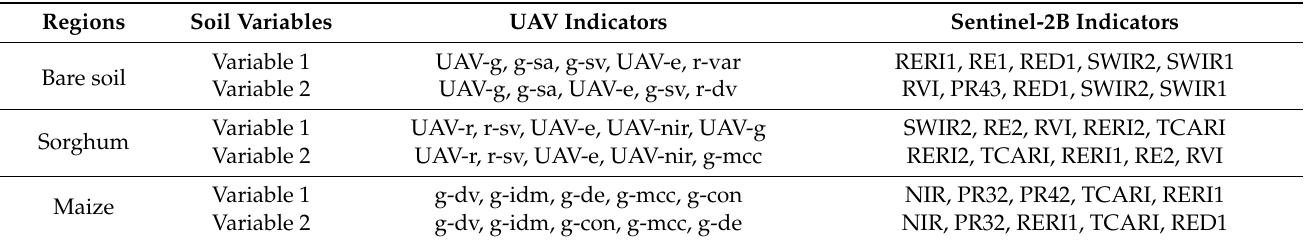
Figure 7. Spearman correlation coefficients ( ρ ) between remote sensing and soil indicators at the: ( a ) bare soil ( n soil = 1182); ( b ) sorghum- ( n sorghum = 1219); and ( c ) maize-cultivated regions ( n maize = 873). Table 3. Remote sensing indicators used for soil variable estimation.